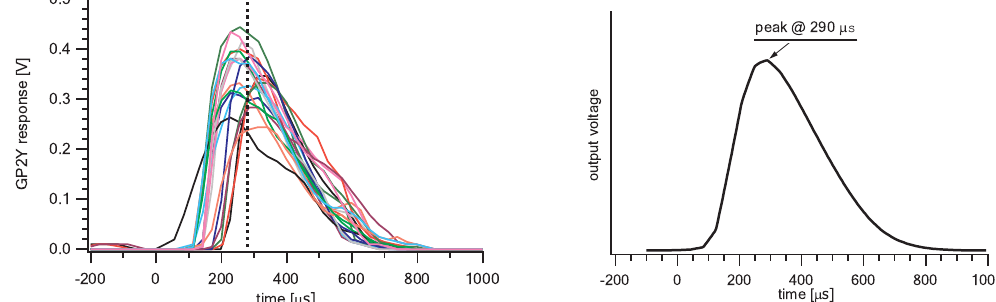
Figure 4. ( Left ) An example set of twenty consecutive recorded real output pulses. The black dotted line corresponds to t = 0.28 ms; ( Right ) the overall average shape of many (several thousands) pulses differs from the manufacturer’s prediction (see Figure 3,